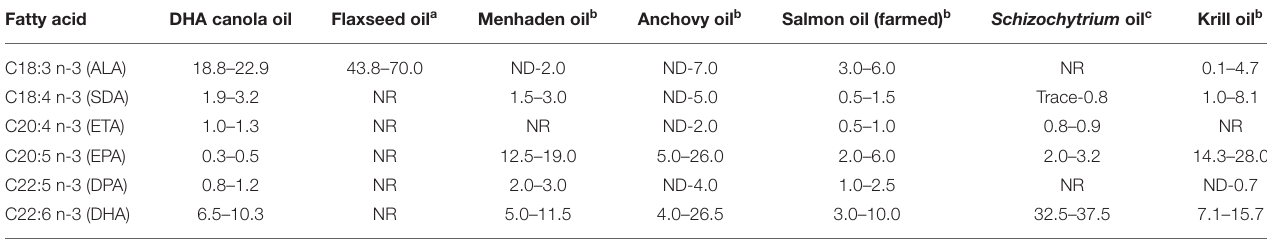
TABLE 5 | ω 3 FA profile of DHA canola oil and multiple ω 3 oil comparators (% of total FA). Fatty acid